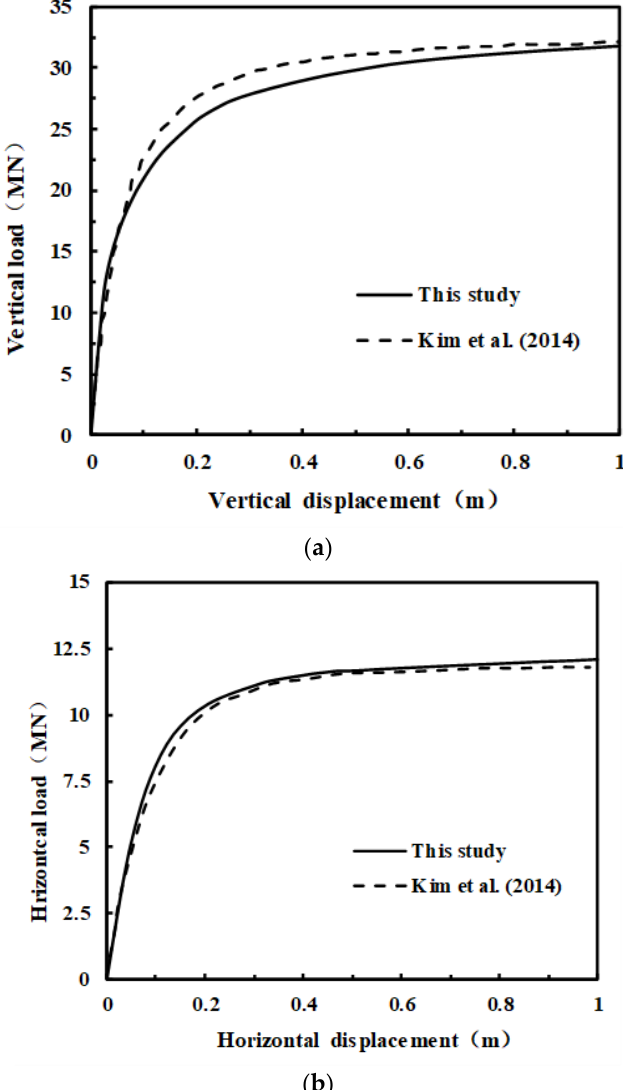
Figure 3. Comparison of load–displacement curves between two methods [14].